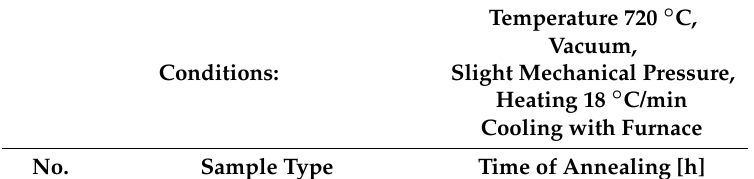
Table 1. The experimental assemblies and conditions. NiA denotes the substrate cut to the parallel direction to the elongation rod, while the NiB in the perpendicular direction.